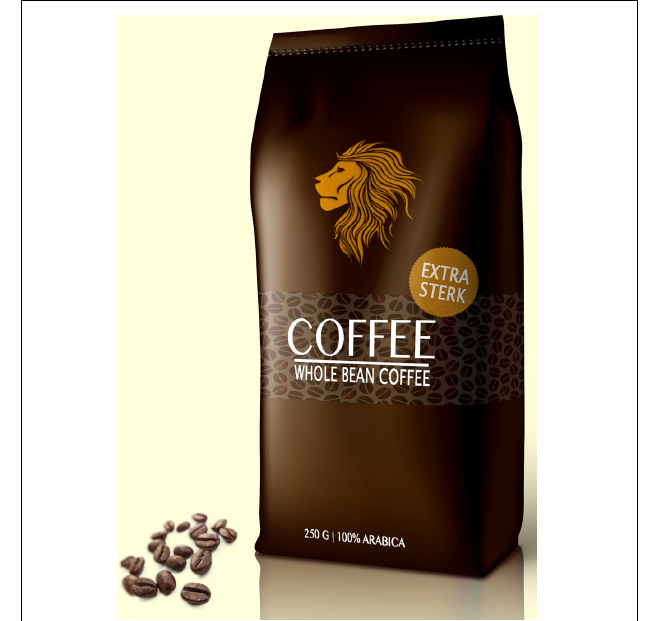
FIGURE 1 | Image on top; the text claim.